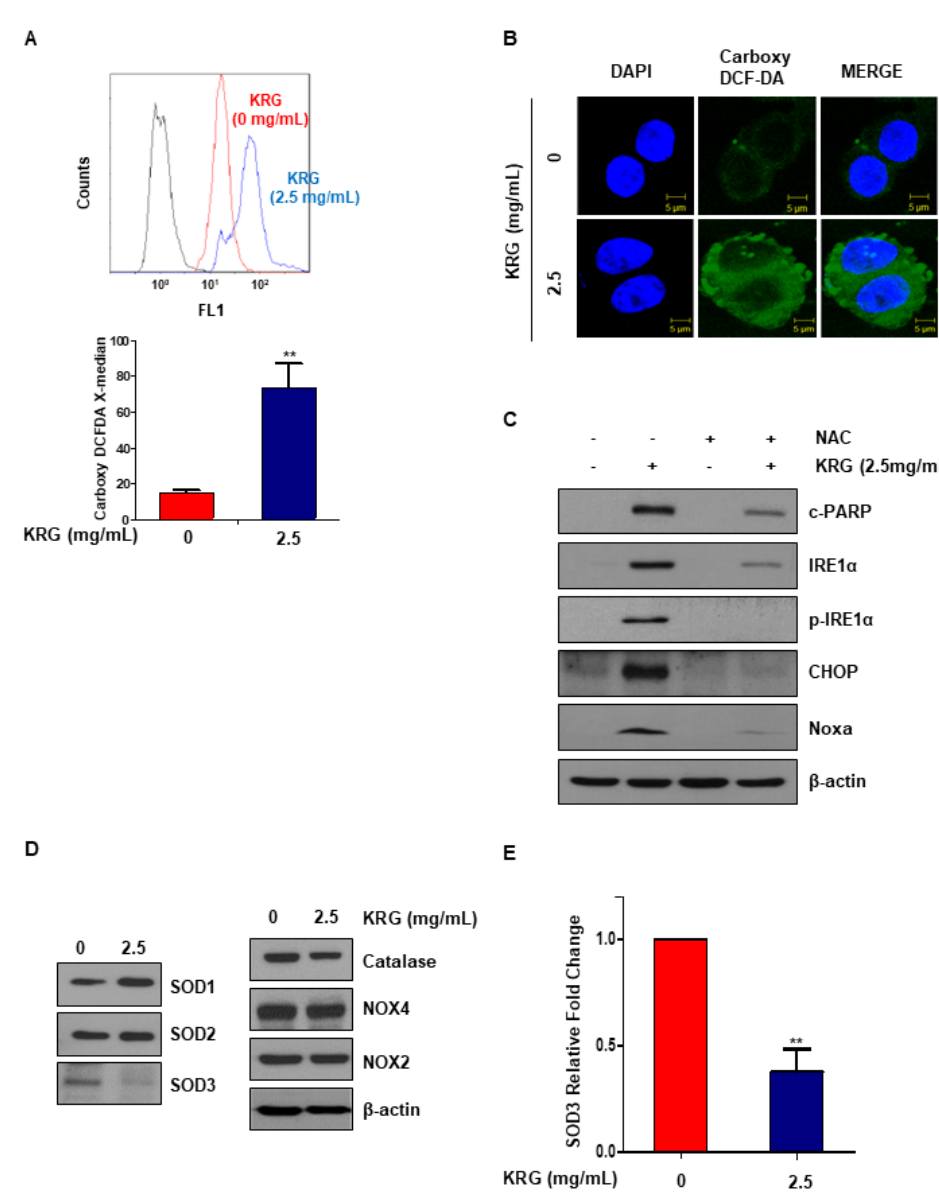
Figure 4. KRG extract induced ROS production. ( A ) HT29 cells were treated with KRG extract (2.5 mg/mL) for 48 h. At 30 min prior to harvest, the cells were treated with carboxy-DCF-DA (10 μ M). The levels of ROS were determined by carboxy-DCF-DA staining and confirmed by flow cytometry. ( B ) ROS generation was assessed by immunofluorescence and confocal microscopy. Scale bar: 10 μ m. ( C ) HT29 cells were pretreated with 10 mM NAC for 2 h, and then treated with 2.5 mg/mL KRG extract for 48 h. The levels of Noxa, CHOP, IRE1 α , p-IRE1 α , and cleaved PARP were detected by western blotting. ( D ) HT29 cells were treated with 2.5 mg/mL KRG extract for 48 h. The expression of SOD1, SOD2, SOD3, catalase, NOX2, and NOX4 were measured by western blotting. (E) The mRNA level of SOD3 was determined by qRT-PCR. The data are shown as the mean of many repeated independent experiments. ** p < 0.01. SOD: superoxide dismutase.